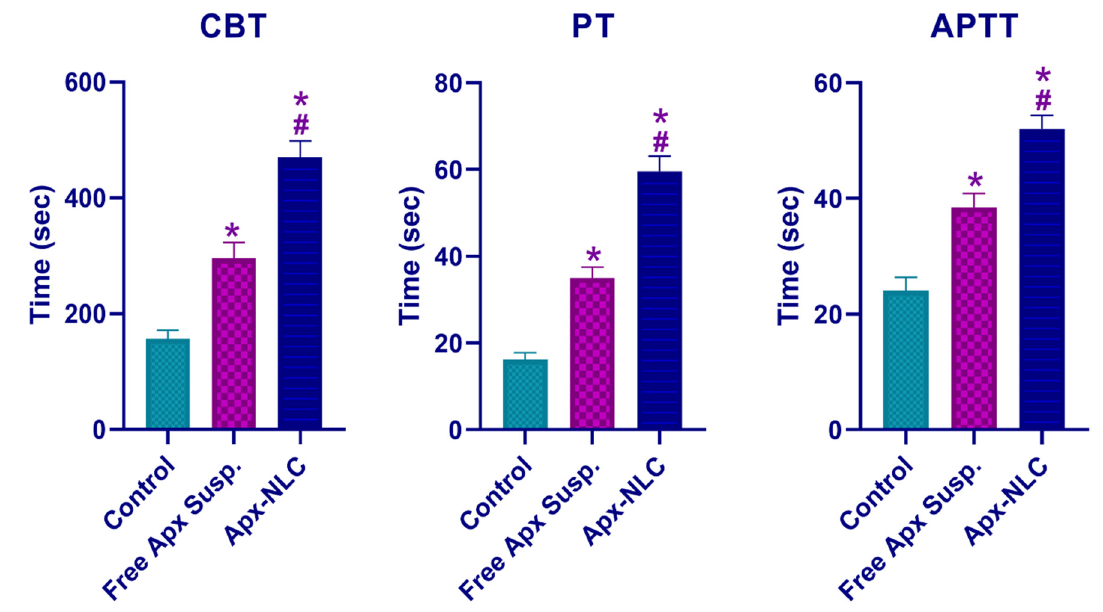
Figure 7. Cuticle bleeding time (CBT), prothrombin time (PT), and activated partial thromboplastin time (APTT) after oral administration of 60 mg/kg of both Apx- NLC and free Apx suspension compared with the control group (mean ± SD, n = 3). Note: * and # denote significant effects at p -values less than 0.05, with the free Apx suspension and control group, respectively.